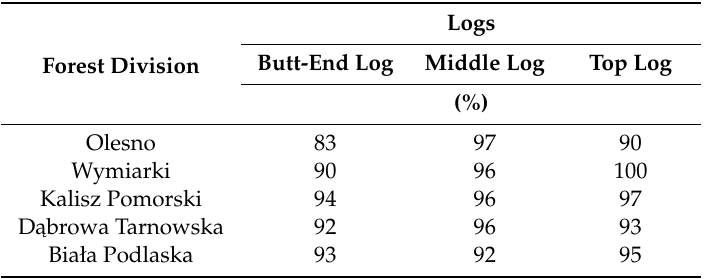
Table 6. The percentage of knots as a factor a ff ecting the quality class of sawn timber in the longitudinal section of long logs for individual forest divisions.